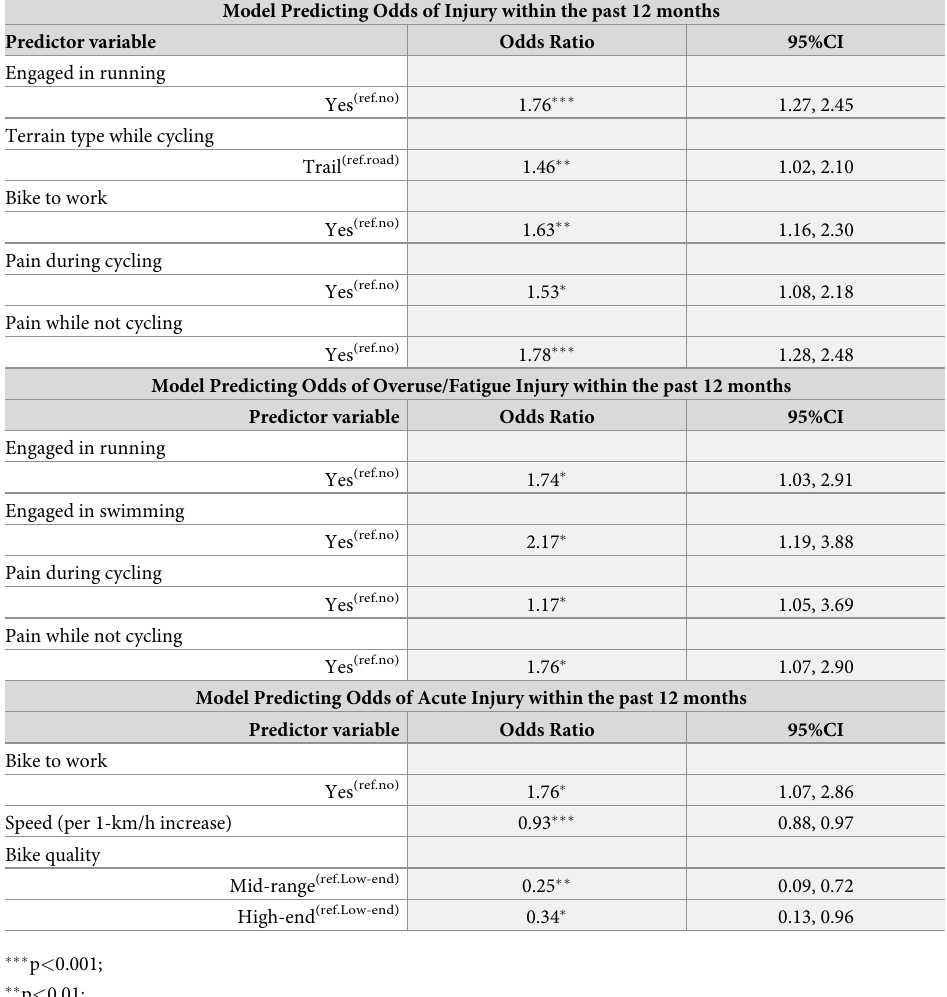
Table 3. Logistic regression model to assess the odds of reporting any injury, overuse/fatigue injury, or acute injury within the past 12 months. Referent category was not reporting an injury. Model Predicting Odds of Injury within the past 12